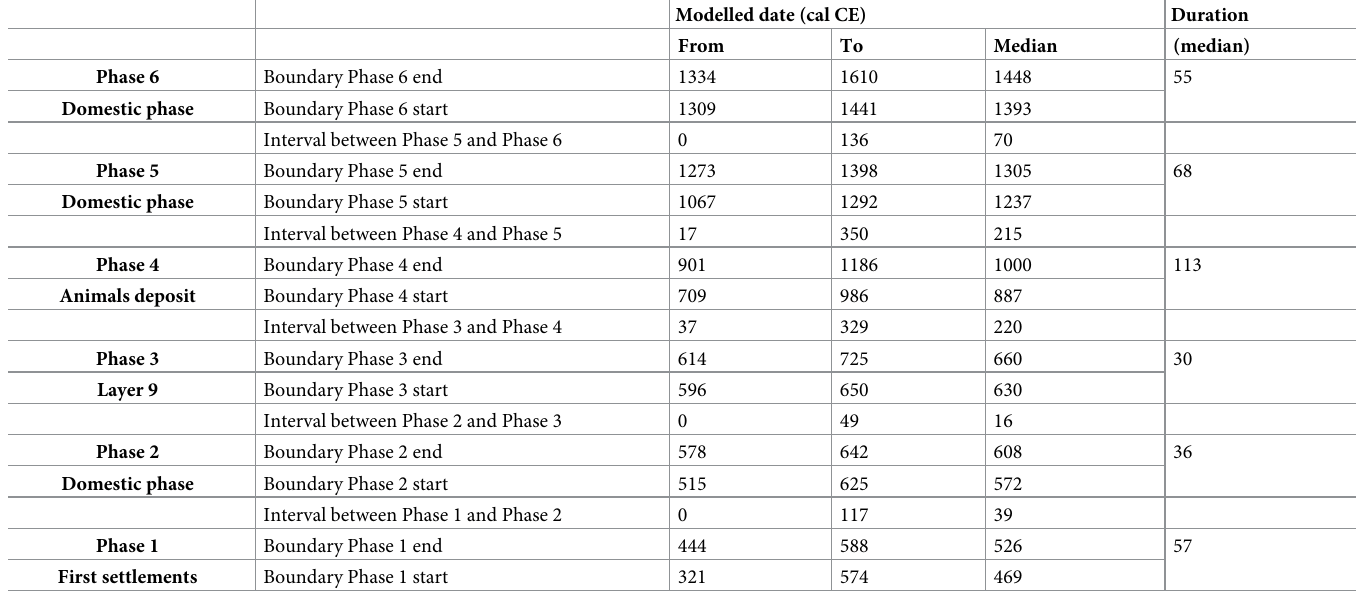
Table 3. Modelled start and end date chronology of the six main occupation phases identified in the Huaca Grande archaeological